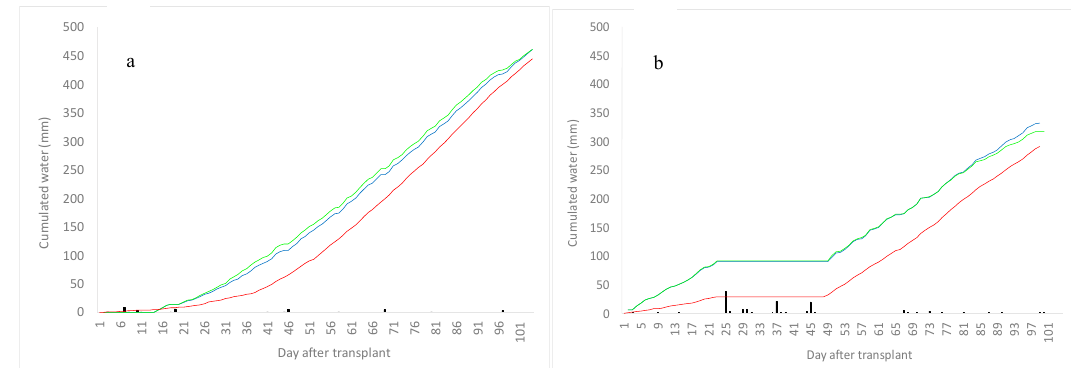
Figure 7. Cumulated irrigation water requirement (mm) estimated by the three methods: AquaCrop (blue), IRRISAT (red) and direct insertion (green) of fractional cover retrieved by Sentinel-2 imagery into AquaCrop, in 2017 ( a ) and 2018 ( b ). Rainfall is also plotted (histograms).